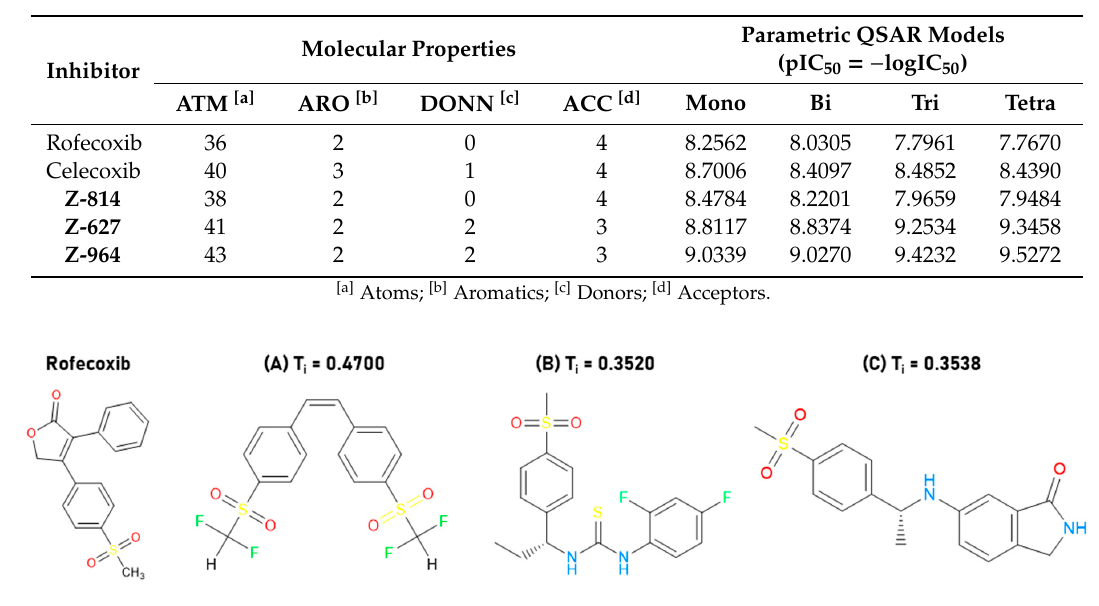
Figure 5. Selected inhibitors with Tanimoto index. ( A ) Z-814 ; ( B ) Z-964 ; ( C ) Z-627 .